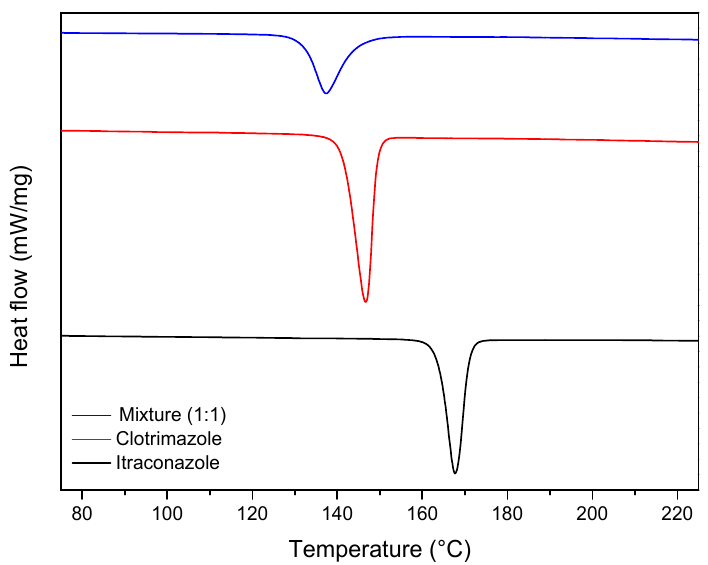
Figure 3. Di ff erential scanning calorimetry (DSC) profile of itraconazole, clotrimazole, and the clotrimazole / itraconazole binary mixture (1:1).